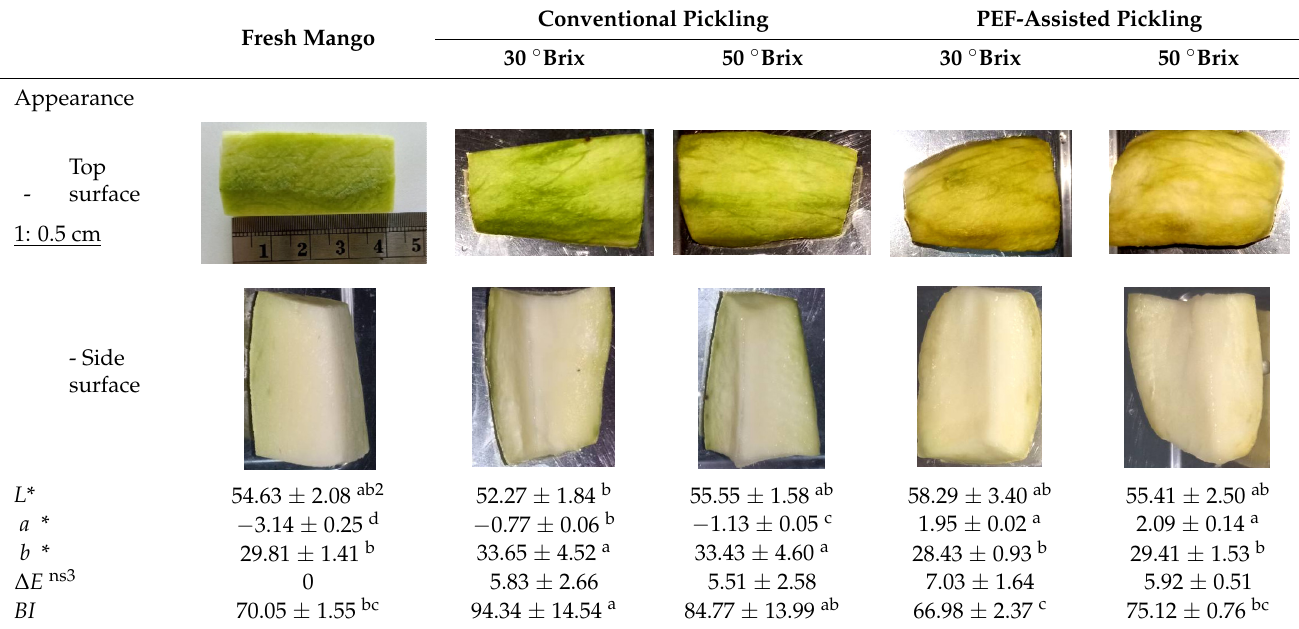
Table 2. Appearance and color values of fresh, conventionally pickled, and PEF-pickled mangoes at the 30 °Brix and 50 °Brix solutions 1 . Fresh Mango